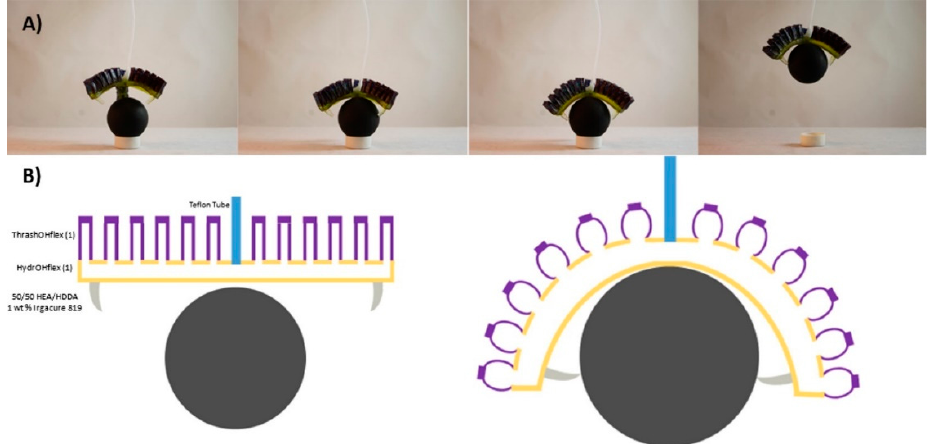
Figure 43. ( A ) Multi-material 3D printed pneumatic gripper, descending, pneumatically actuating, and grabbing a plastic ball. ( B ) Schematic illustration of the multi-material gripper before ( left ) and after ( right ) pneumatic actuation. Ball diameter = 38 mm. Reproduced from [347].